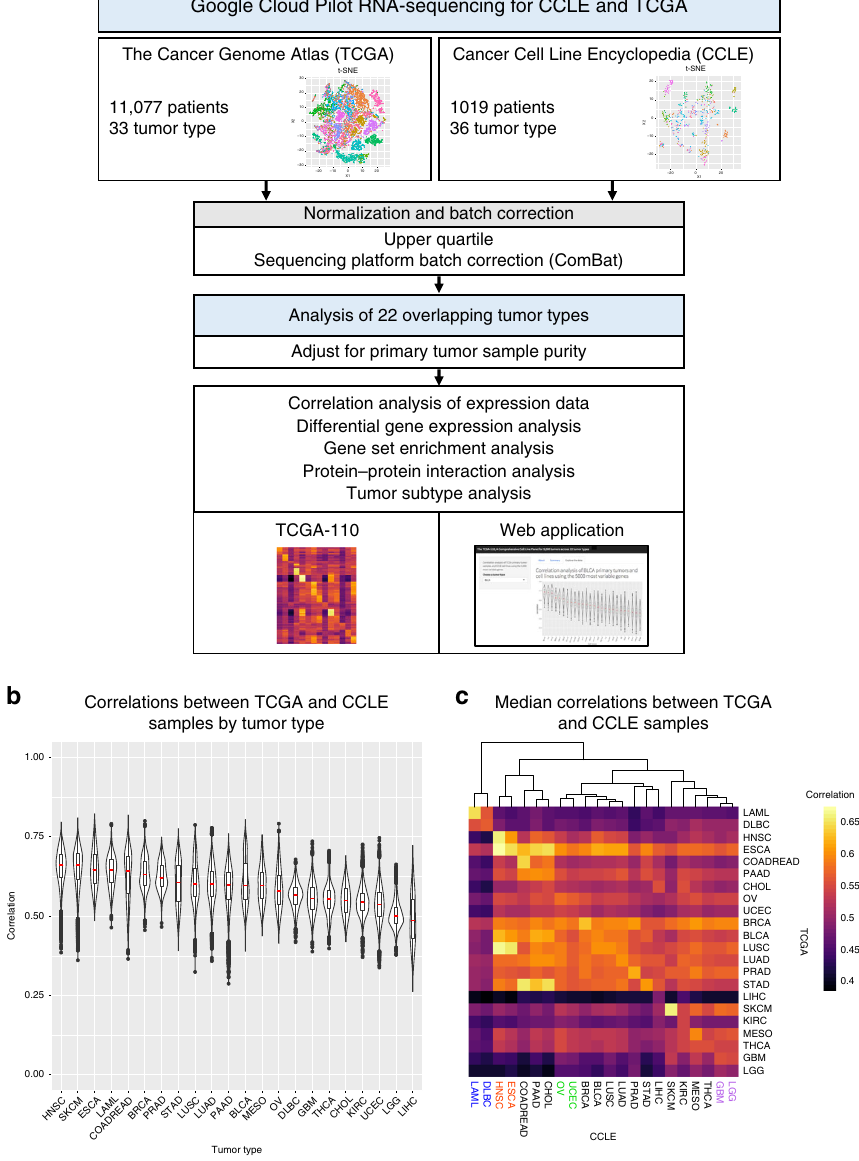
Fig. 1 Pan-cancer analysis of cell lines and matching primary tumor samples. a Study design. RNA-seq data were downloaded from the Google Cloud Pilot RNA-sequencing for CCLE and TCGA project for 22 cancer types that overlapped between the CCLE and TCGA data sets. The data were normalized, batch corrected, and adjusted for tumor purity during the analysis. b Correlation analysis of the CCLE and TCGA data. Each sample in the violin plot corresponds to the Spearman correlation between one cell line and one primary tumor sample using the 5000 most variable genes. In the overlaid boxplot, the red center line depicts the median, the box limits depict the upper and lower quartiles, and the whiskers depict 1.5 times the interquartile range. c Heatmap of median correlations between all tumor types in CCLE compared with all tumor types in